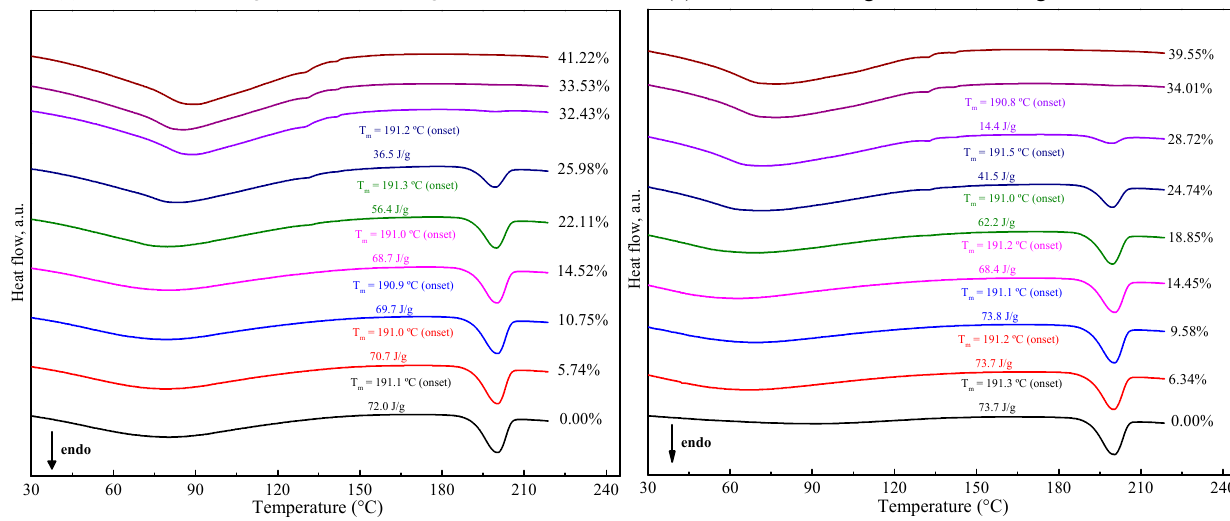
Figure 5. DSC thermogram of tablet formulation by wet-granulation process with different water contents in 2 L ( a ) and 4 L ( b ) granulators. The enthalpy values have been normalized for the FXD content in formulation.